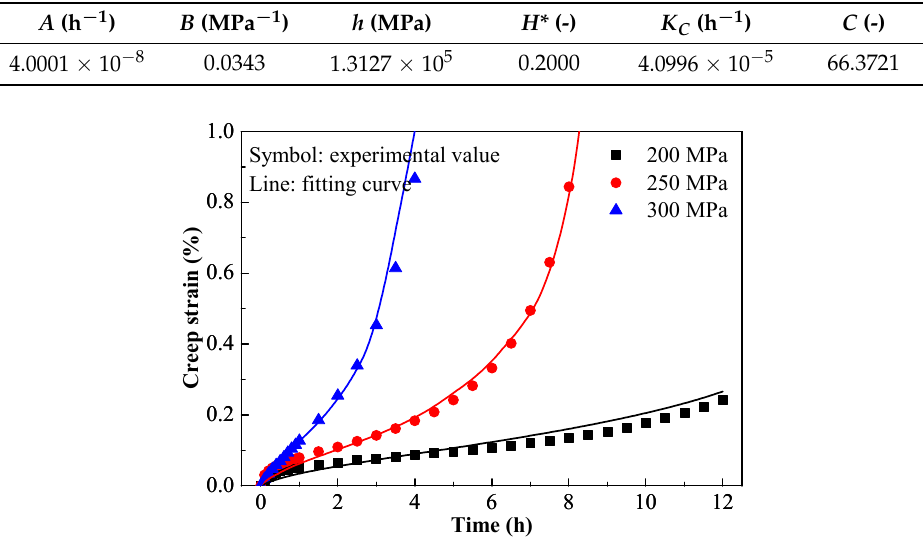
Table 2. Material constants of AA7050 in continuous damage mechanism (CDM) model.